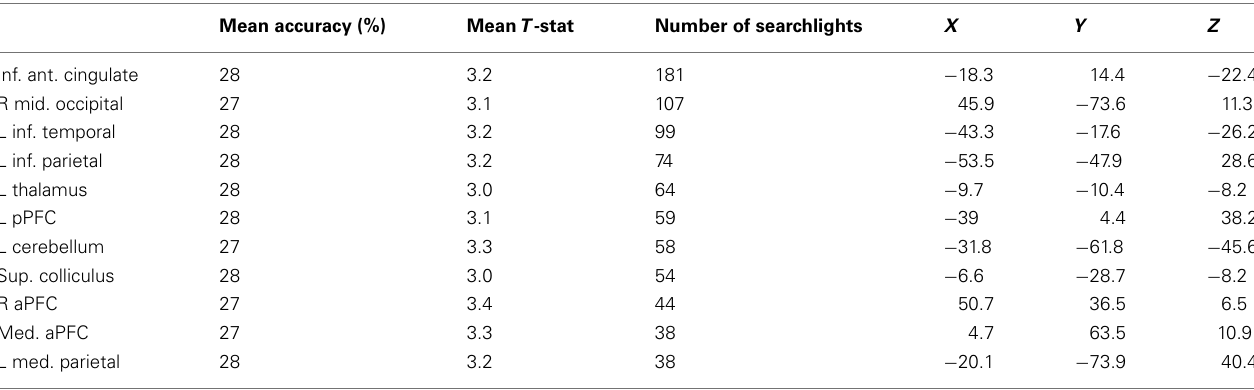
Table 7 |Whole brain semantic rule searchlight